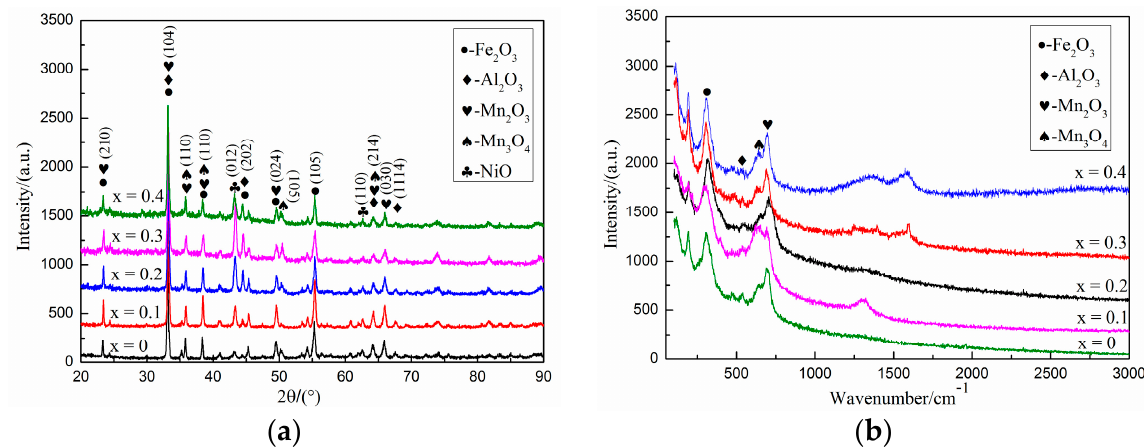
Figure 7. XRD pattern and Raman pattern of the surface layer of Fe-25Mn-9Al-8Ni-1C-xTi alloy oxidized for 200 h. ( a ) XRD pattern; ( b ) Raman pattern.